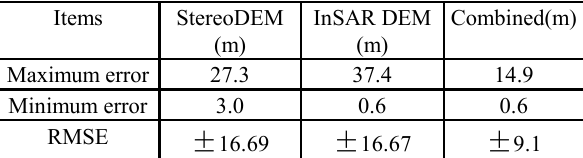
Table 1. DEM accuracy